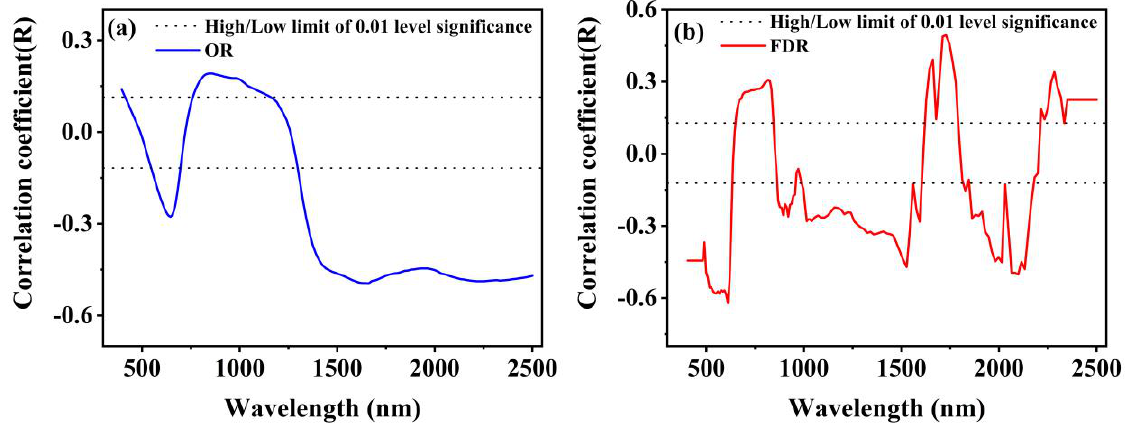
Figure 4. Correlation coefficient of SOM content with spectral wavelength, (( a ) OR; ( b ) FDR). Table 3. Correlation coefficient significant correlation band information.